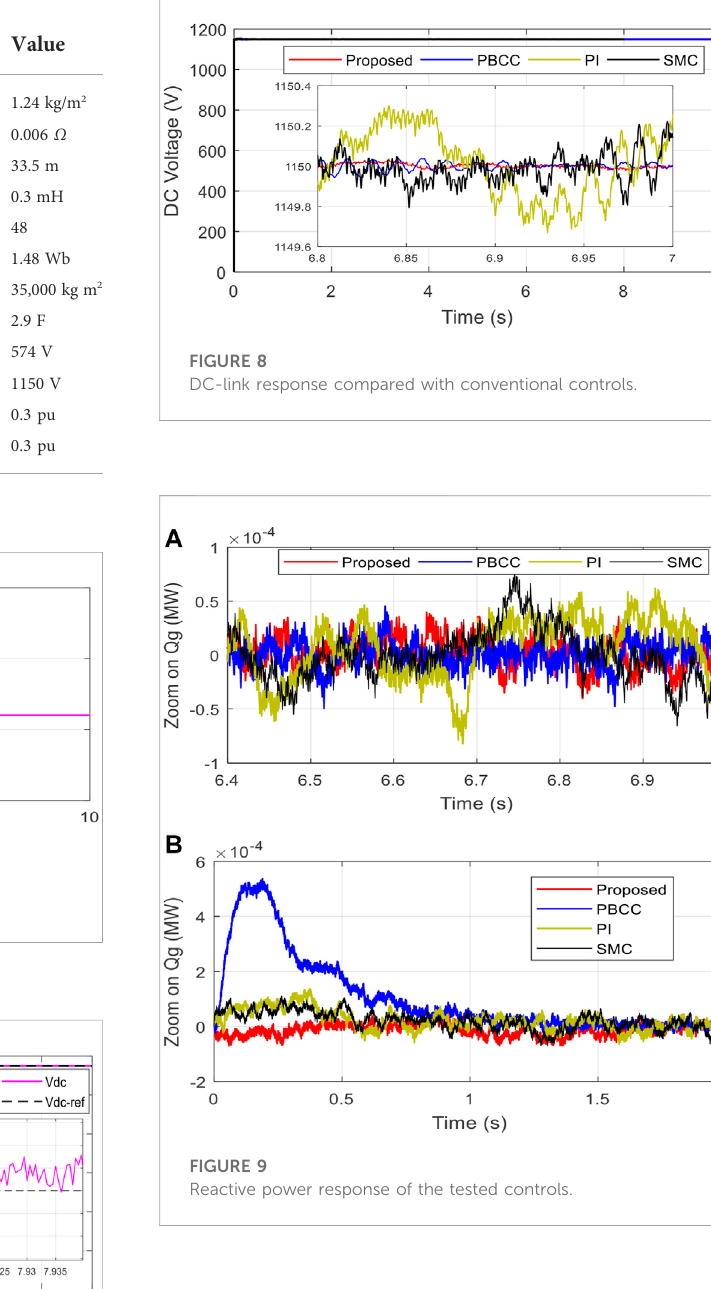
TABLE 2 Parameters of the system.